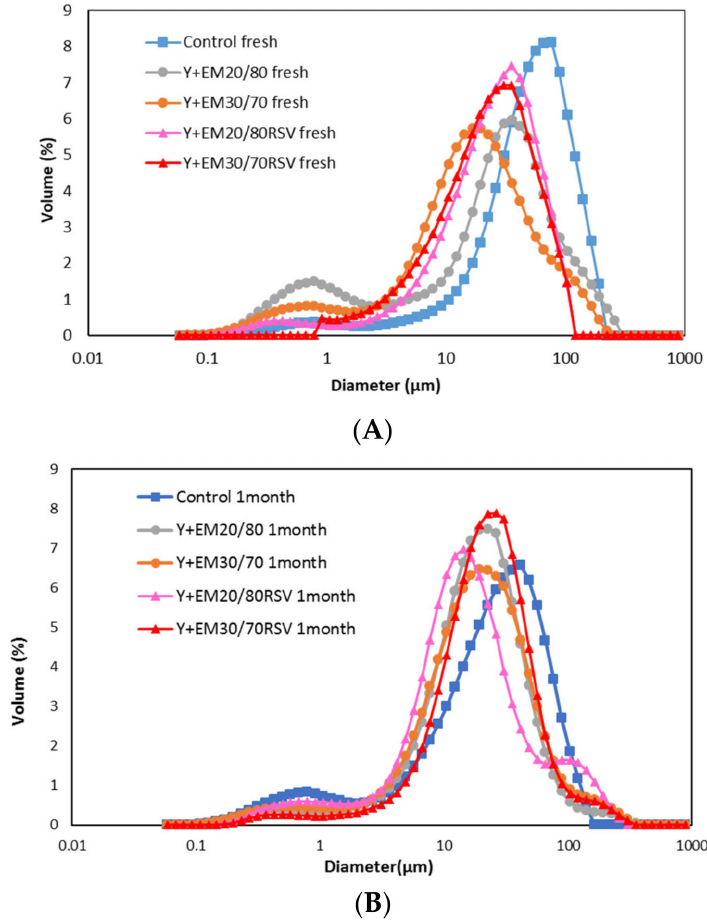
Figure 1. Droplet size distribution of the control yoghurt and of the yoghurts with double emulsions formulated by varying the volumetric ratio of the dispersed phase (primary emulsion W 1 /O) in relation to the external aqueous phase (W 2 ), fresh ( A ) or after storing 1 month at 4 ◦ C ( B